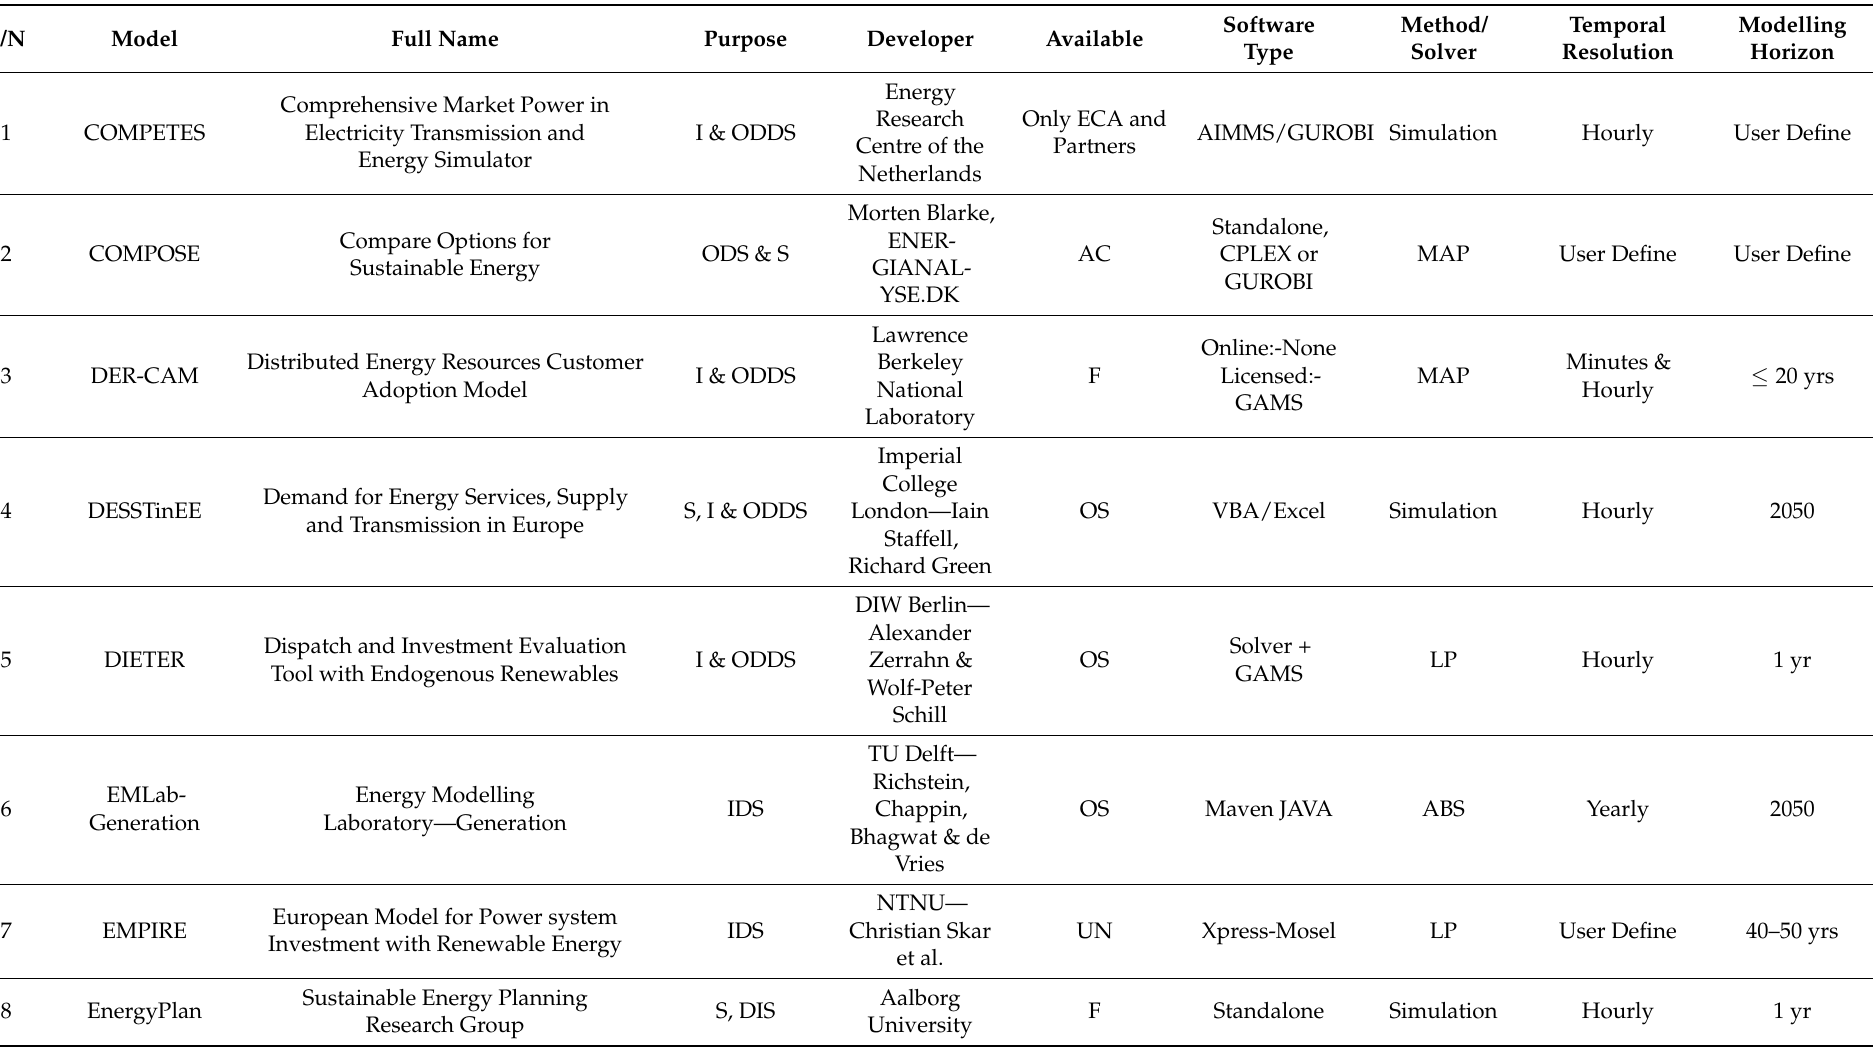
Table 3. Review of some selected energy modelling tools